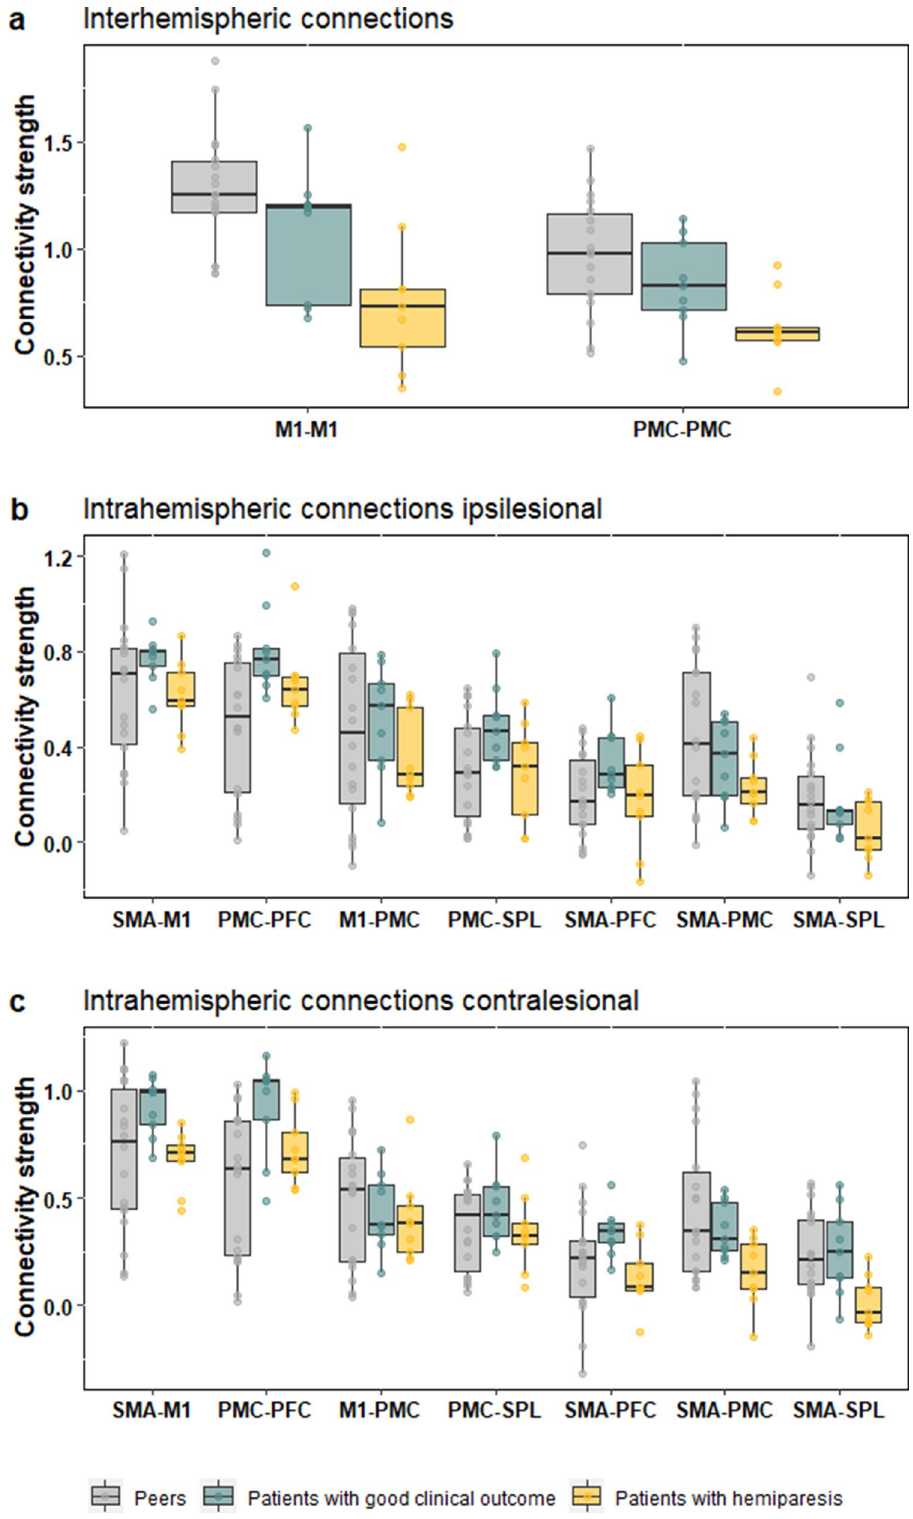
Figure 1. Comparison of connectivity strength. For typically developing peers (gray), patients with good clinical outcome (green), and patients with hemiparesis (yellow), the boxplots show the ROI-to-ROI connectivity strength within the motor network including the prefrontal cortex (PFC), dorsal premotor cortex (PMC), the primary motor cortex (M1), the supplementary motor area (SMA), and the superior parietal lobe